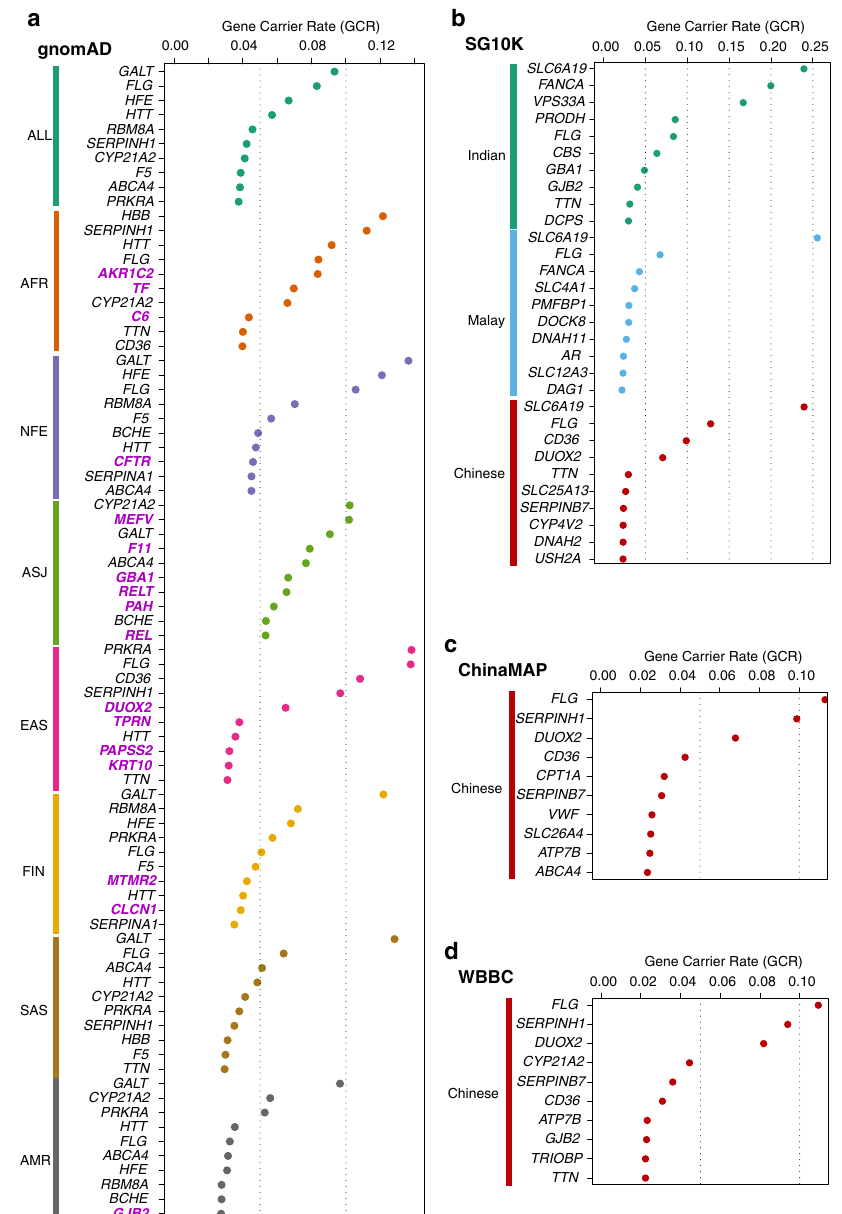
Fig. 3 Gene carrier rates (GCRs) for the top ten genes of each ethnicity within each cohort. Genes are listed on the vertical axis, and the GCR values are shown on the horizontal axis. a gnomAD cohort containing GCRs from seven subpopulations. ALL all gnomAD samples, AFR African/African American, NFE European (non-Finnish), ASJ Ashkenazi Jewish, EAS East Asian, FIN European (Finnish); SAS South Asian, AMR Latino/Admixed American. Note that ethnicity-speci fi c top gene(s) not in any other ethnicity ’ s top 10 gene lists were highlighted in bold with purple color. b Singapore cohort containing GCRs from three subpopulations. c ChinaMAP cohort and d WBBC cohort both composed of Chinese population